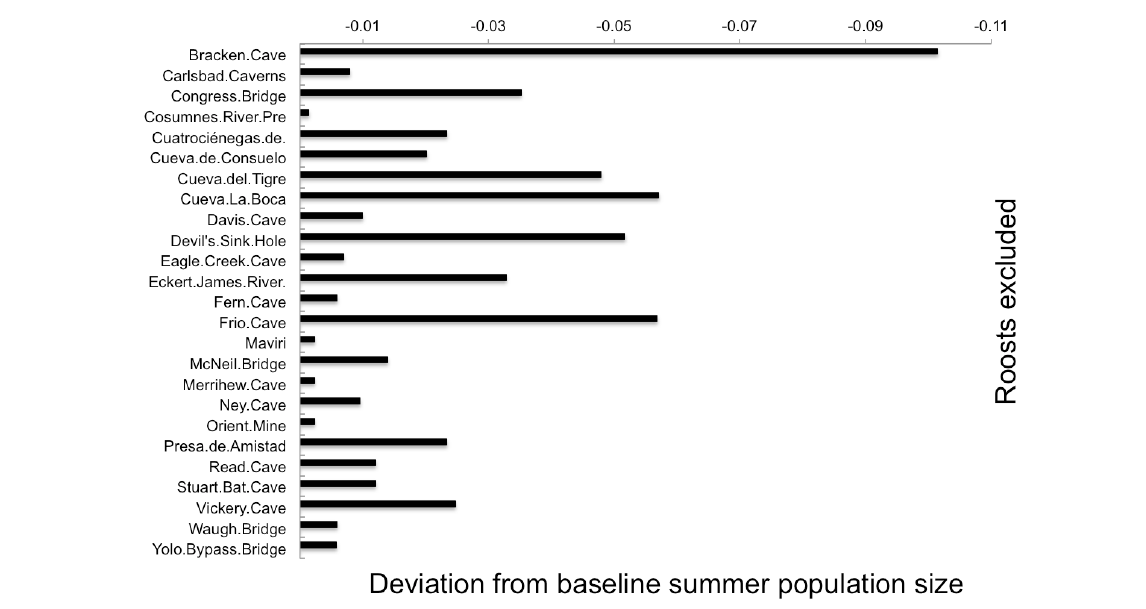
Fig. 2 . Results of the habitat removal experiment. Changes in summer population size with eliminated habitat (each breeding roost site and winter region) are expressed as the proportional difference from the baseline summer population size (i.e., the summer population with no